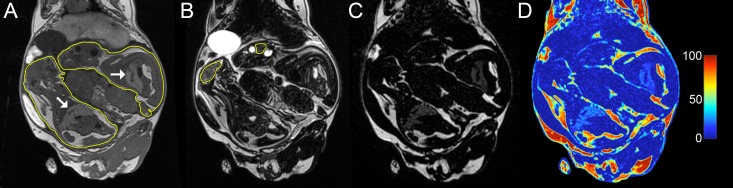
Coronal images of a pregnant guinea pig on a lifetime Western Diet.(A) T1-weighted image with fetuses contoured in yellow and fetal livers denoted by white arrows. (B) T2-weighted images with fetal brains contoured in yellow. (C) IDEAL fat-only image. (D) IDEAL fat fraction map. Images have been cropped to highlight the fetuses.